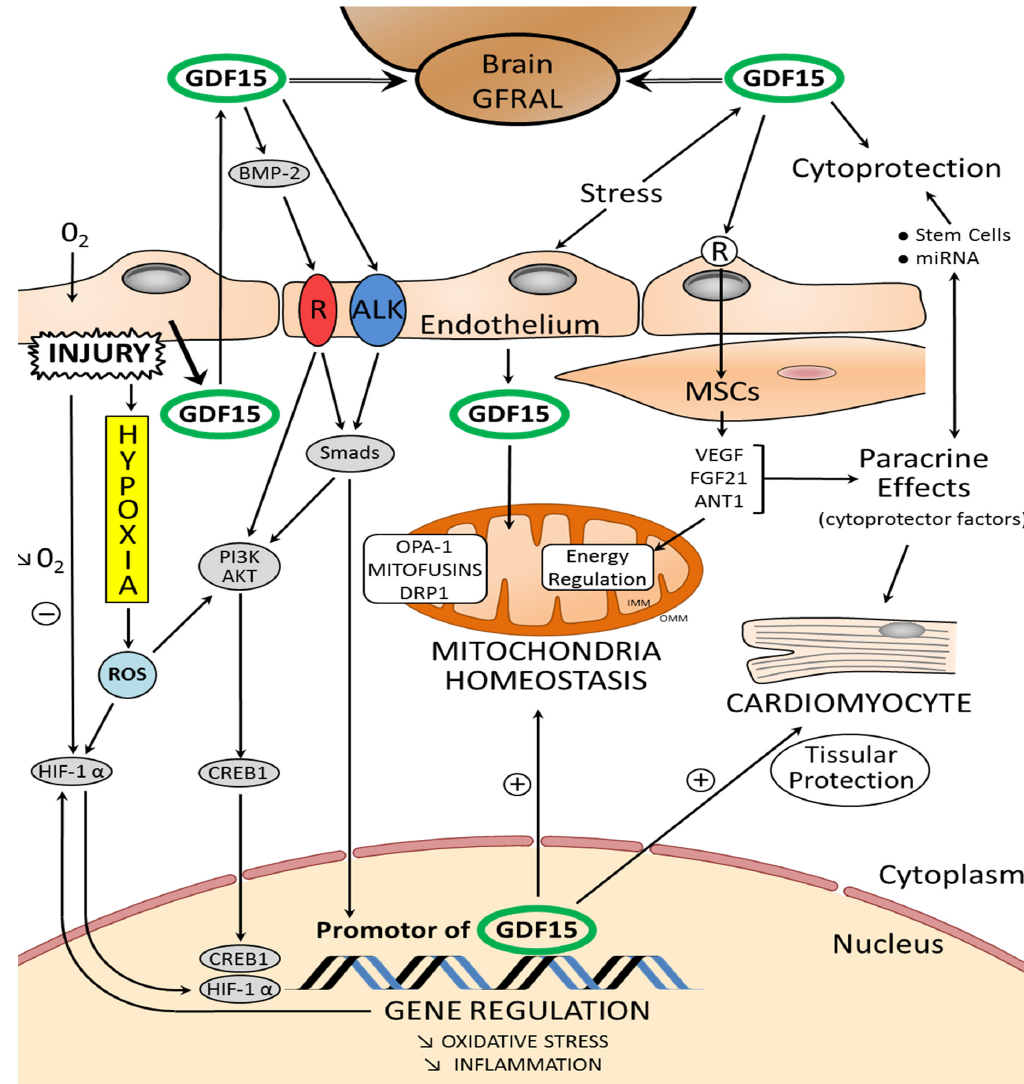
Figure 2. Schematic representation of the relationship between mitochondrial homeostasis and the properties of GDF15: GDF15 modulates mitochondrial functions by inducing mitochondria-related genes. OMM: outer mitochondrial membrane, IMM: inner mitochondrial membrane. In the figure, the main proteins orchestrating mitochondrial homeostasis are highlighted: DRP1, dynamin-related protein 1; Mfn 1–2, mitofusin 1 and 2; OPA-1: optic atrophy protein-1. Fibroblast growth factor 21 (FGF21) and adenine nucleotide translocator isoform 1 (ANT1) are regulators of mitochondrial metabolism. The paracrine mechanisms, mediated by factors released by the stem cells and implicating microRNAs (miRNA), play a role in cytoprotection of the myocardium. Exosomes, especially those secreted by different cardiac stem cells, confer cardioprotective effects. Stem cells and muscular smooth cells (MSC) secrete growth factors such as vascular endothelial growth factor (VEGF) and fibroblast growth factor-2 (FGF-2). Tissue damage and cellular stress induce the expression and secretion of GDF15 from various cells in the myocardium. Glial-derived neurotrophic factor (GDNF) family receptor α -like (GFRAL) is an endogenous receptor for GDF15; it is identified selectively in some areas of the brain. GDF15 interacts on endothelial cells with a receptor-pair consisting of activin receptor-like kinase (ALK). GDF15 regulates the signaling pathways that are essential for regulating proliferation and angiogenesis through activation of ALK receptors and phosphorylation of Smad. GDF15 activates PI3K/AKT. The AKT pathway is directly linked to C-AMP response element-binding protein (CREB1) activation. Subsequently, activated CREB1 acts as transcription factor in the nucleus by directly binding the promoter region of GDF15. After myocardial injury and hypoxia, hypoxia-inducible factors (HIFs) are molecular mediators of the response to hypoxia. HIF-1 α is a transcription factor and GDF15 activates the HIF-1 α signal (+: stimulation; − : inhibition; ↓ :